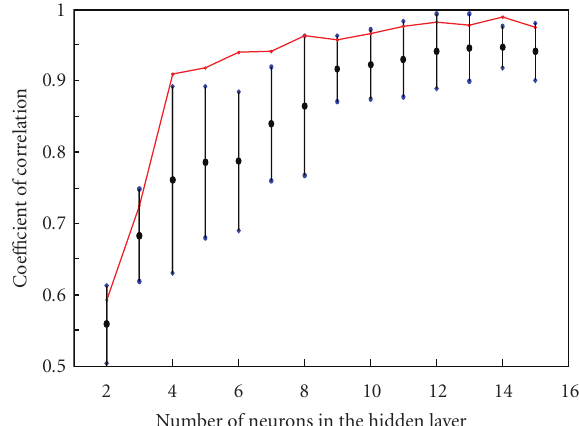
algorithm. Design and learning of artificial neural networks